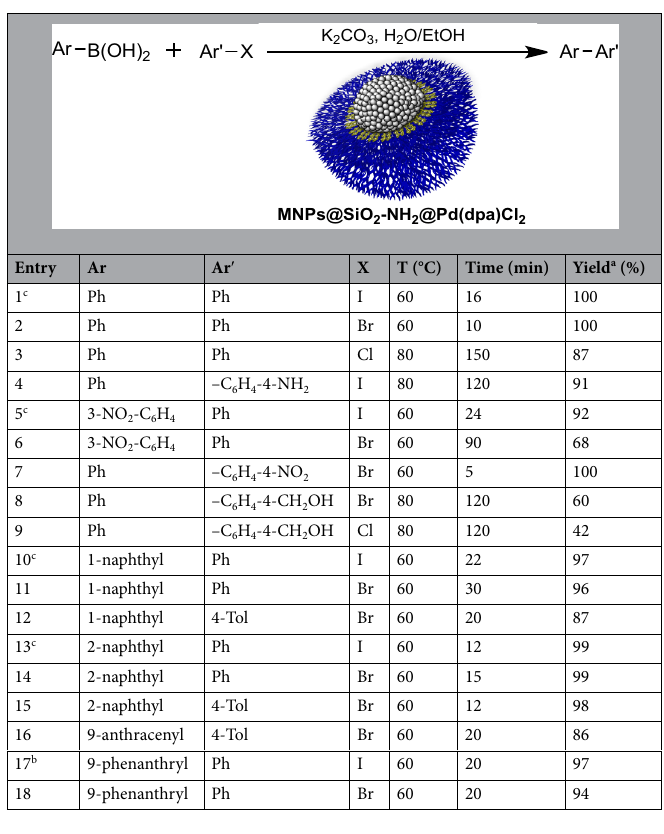
Table 1. Suzuki–Miyaura coupling of aryl halides with aryl boronic acids employing MNPs@SiO 2 -NH 2 @